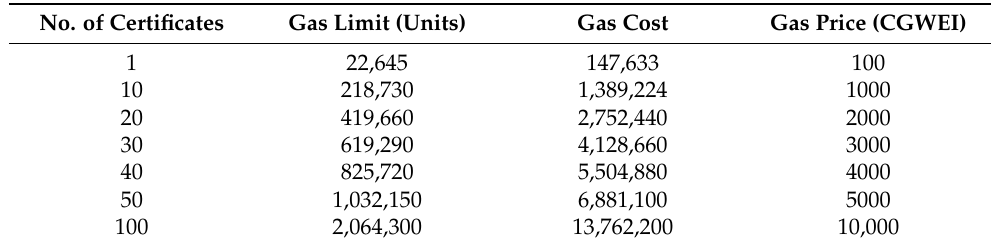
Table 3. Smart contract cost analysis generated using Blocksim. Reprinted/adapted with permission from Ref. [44]. 2021